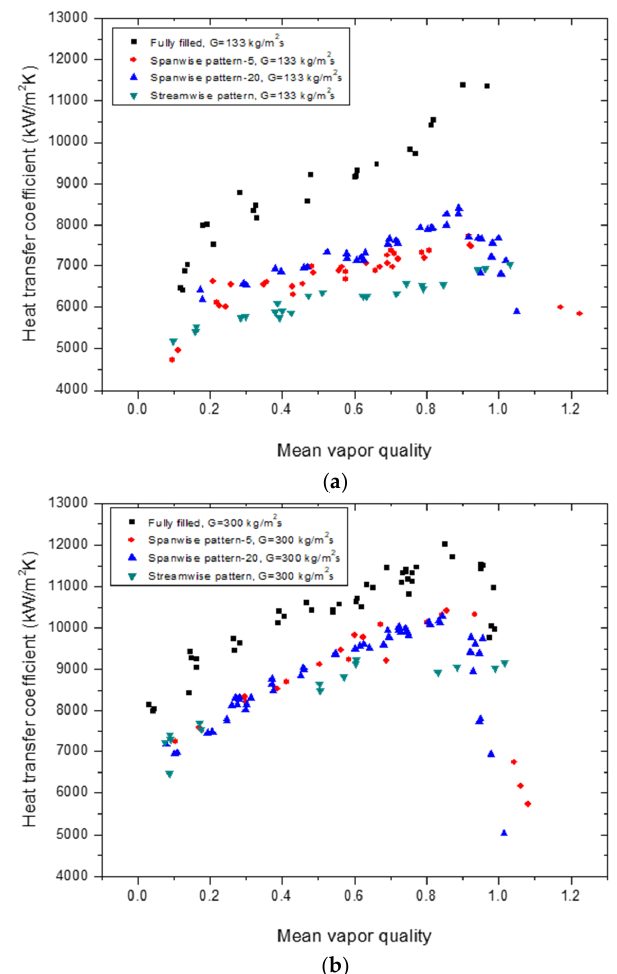
Figure 7. Comparison of the boiling HTC per unit mass flux at ( a ) G = 133 kg/m 2 s and ( b ) G = 200 kg/m 2 s for different patterned models of porous media with a fully filled porous media channel.